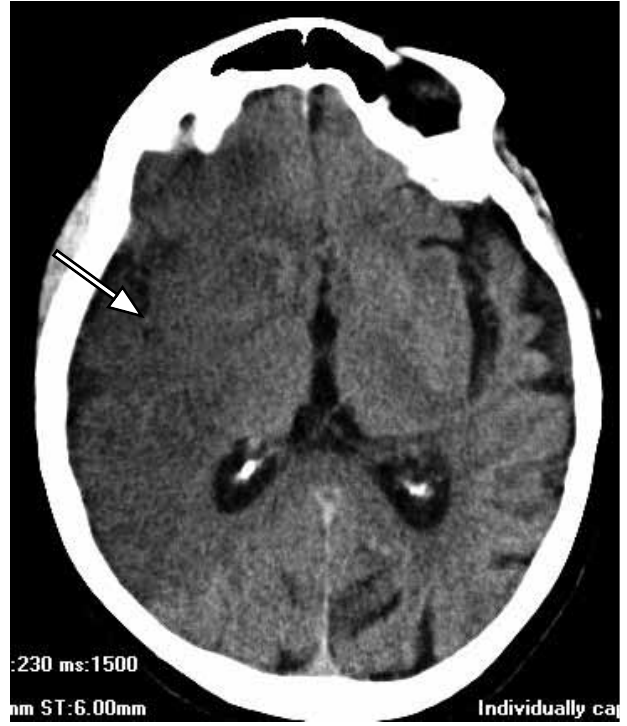
Fig. 2. Non-enhanced axial CT brain of the same patient (at the level of the sylvian fissures) demonstrates a hyperattenuating dot (arrow) in the partially attenuated right sylvian fissure, which is more opaque (measuring 70 HU) than any structure in the ipsilateral or contralateral sylvian fissure — the MCA dot sign.